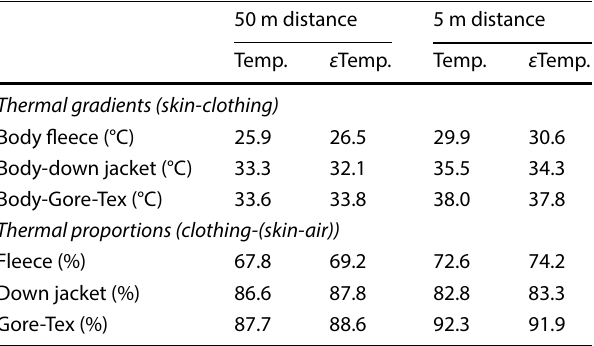
Thermal gradients (skin-clothing) were calculated between body temperature (skin) and textile clothing surface. Thermal propor- tions (clothing-(skin-air)) were calculated as the proportion of measured clothing surface temperature and the gradient